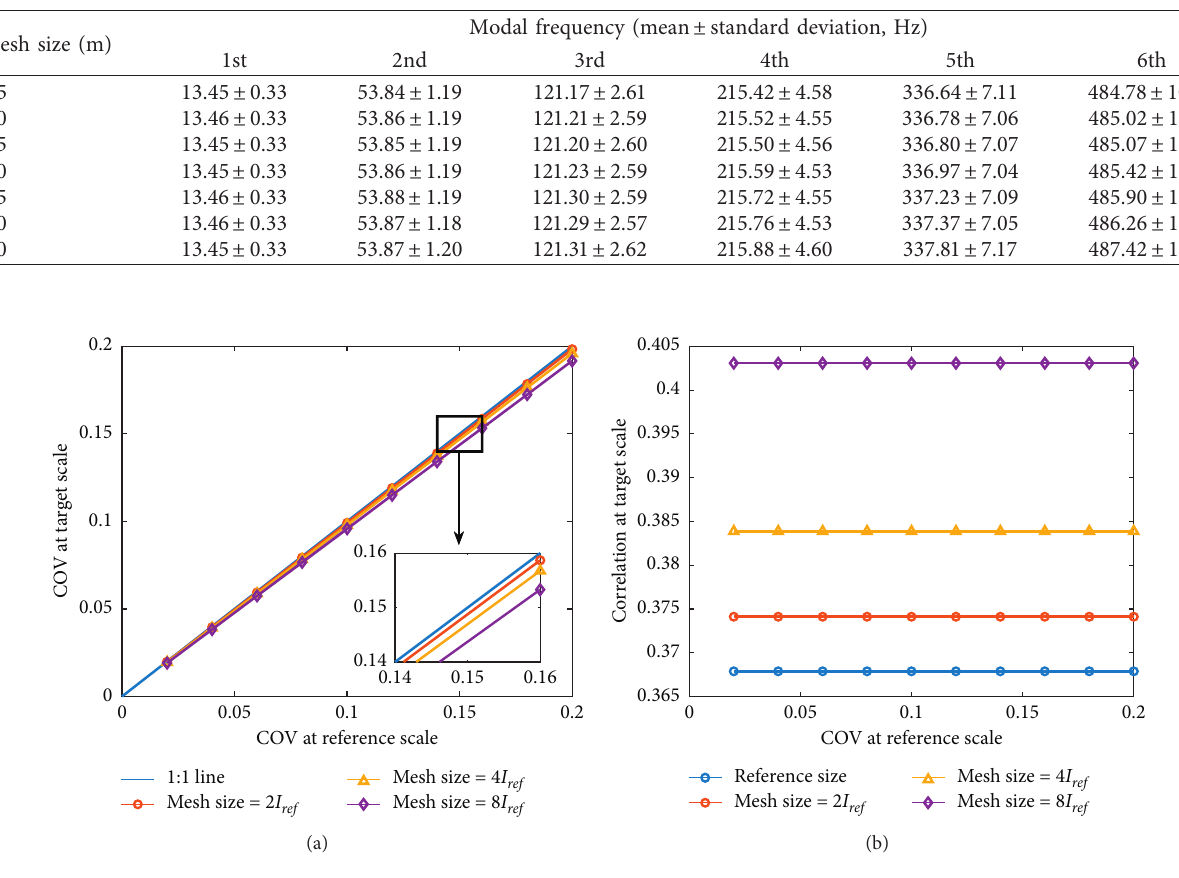
Figure 11: Random field statistics for different values of COV at the reference scale: (a) COV at the target scale and (b) correlation at the target scale when the separation distance is 16m (i.e., about half of the scale of